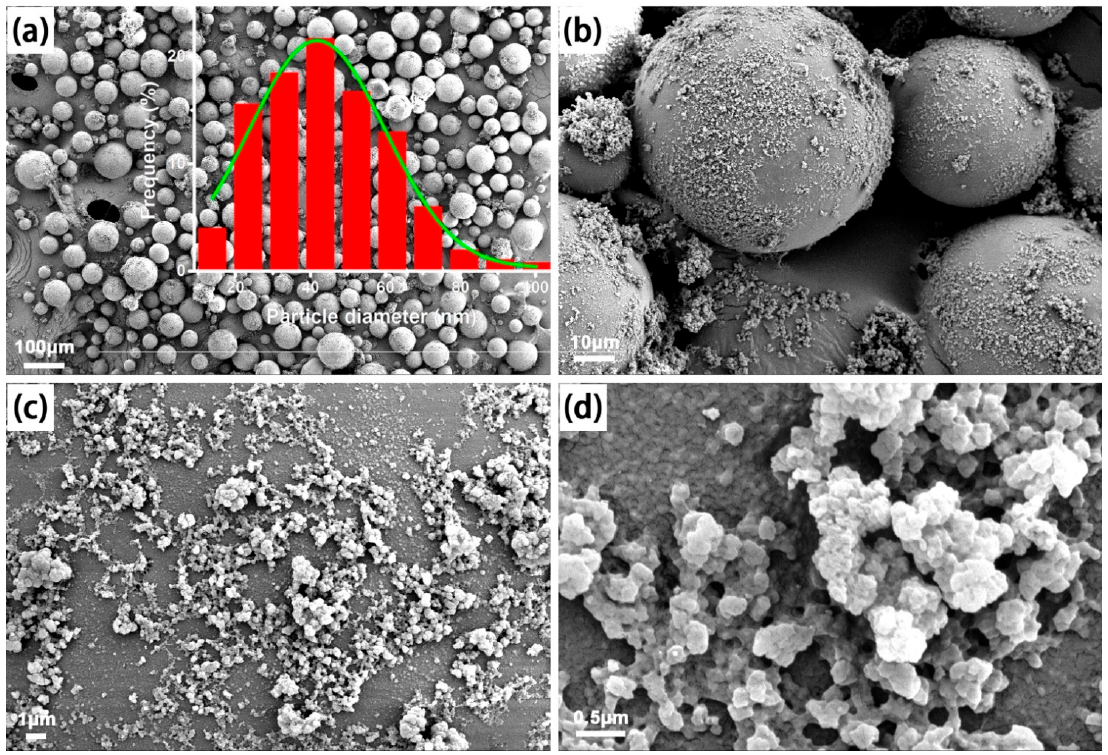
Figure 3. ( a – d ) SEM images of the NIPMs prepared without the molecular imprinting treatment and the inset in ( a ) shows the particle size distribution histogram.